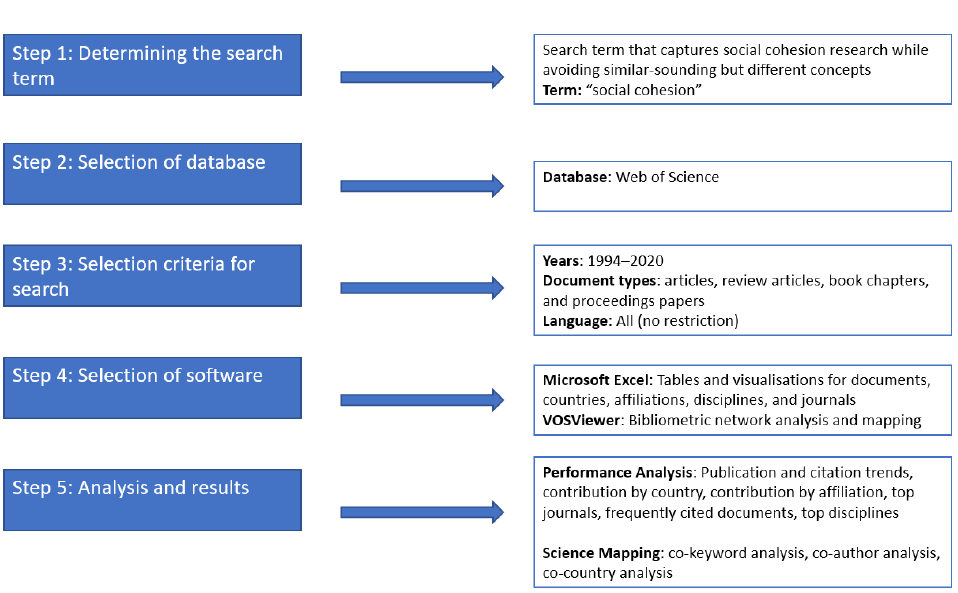
Figure 1. Methodological scheme for the bibliometric analysis.